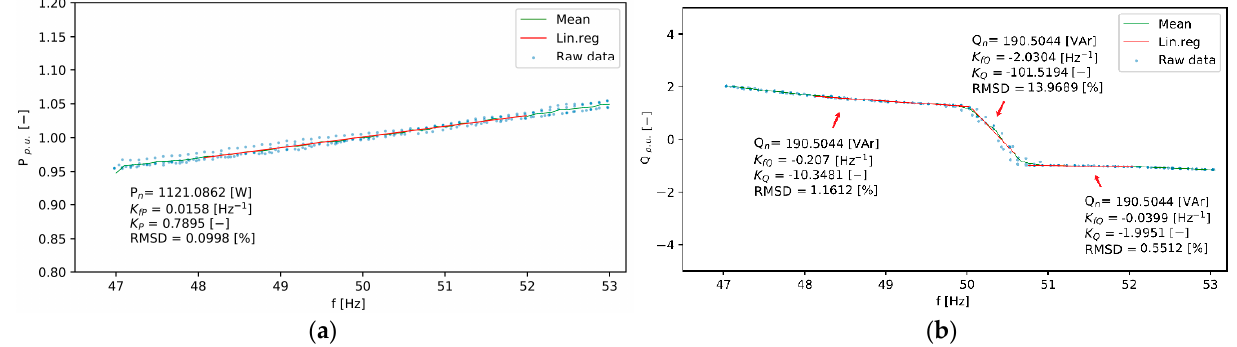
Figure 8. Analyzed load static characteristics of air conditioner ( a ) K P , K fP ; ( b ) K Q , K fQ .